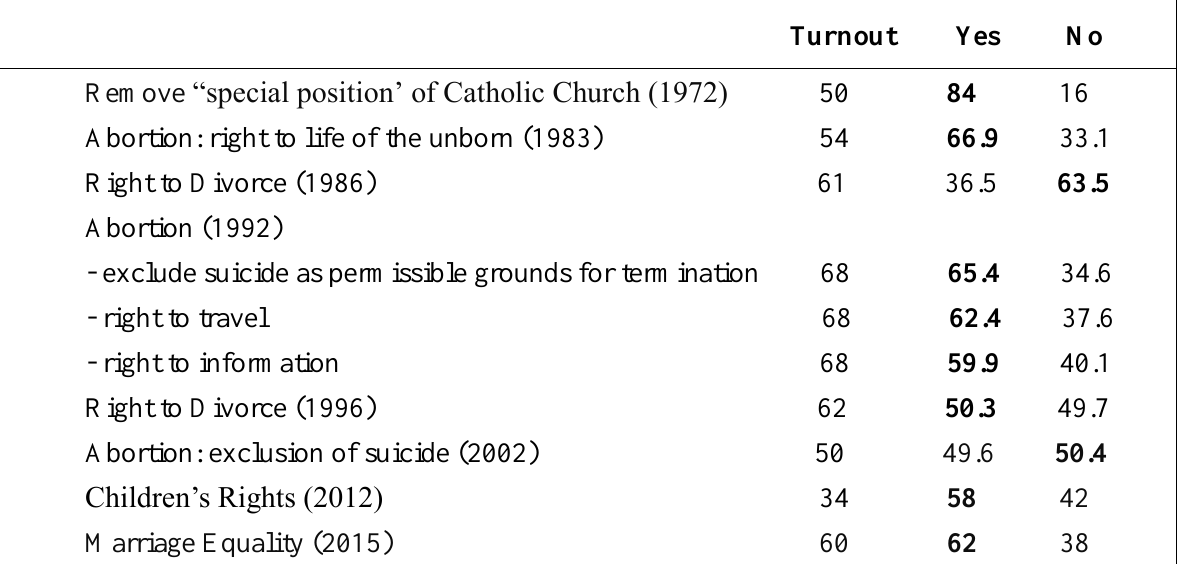
Table 2. Catholic Social Referendum Results: